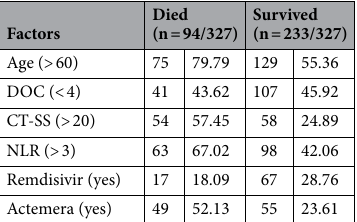
Table 4. Characters of validity cohort. The parametric data presented as mean and stander deviation (SD), and categorical data as number and percentage (%).